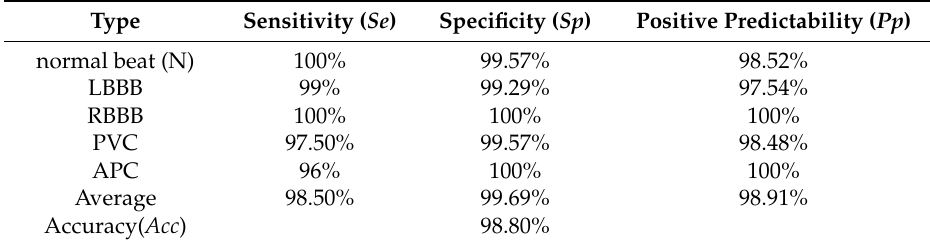
Table 3. Statistical performance indicators of the SVM classifier: sensitivity ( Se ), specificity ( Sp ), and positive predictability ( Pp ).